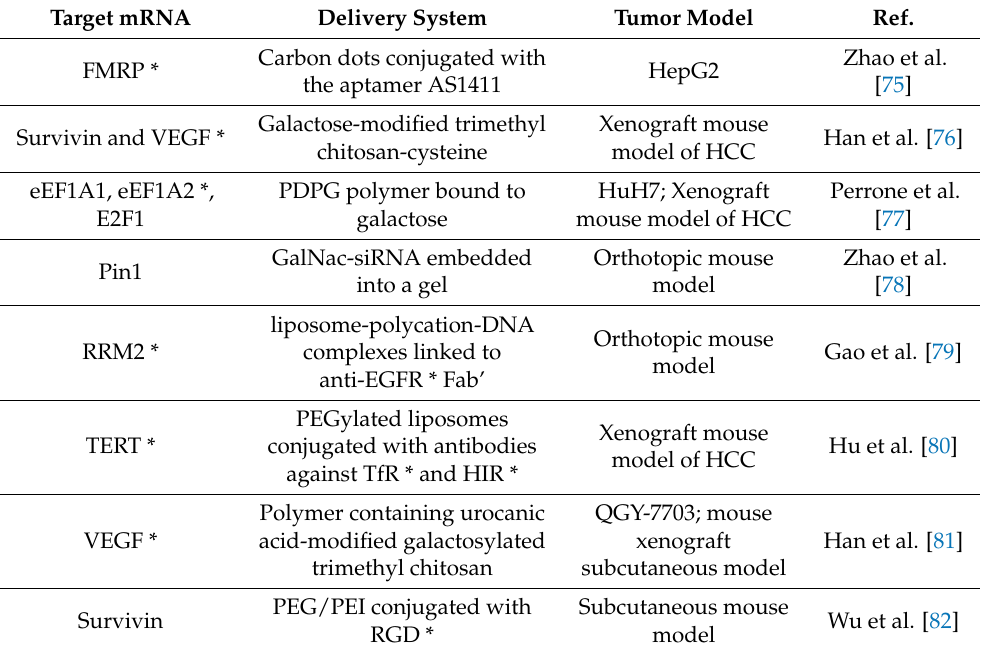
Table 5. siRNA employment in hepatocellular